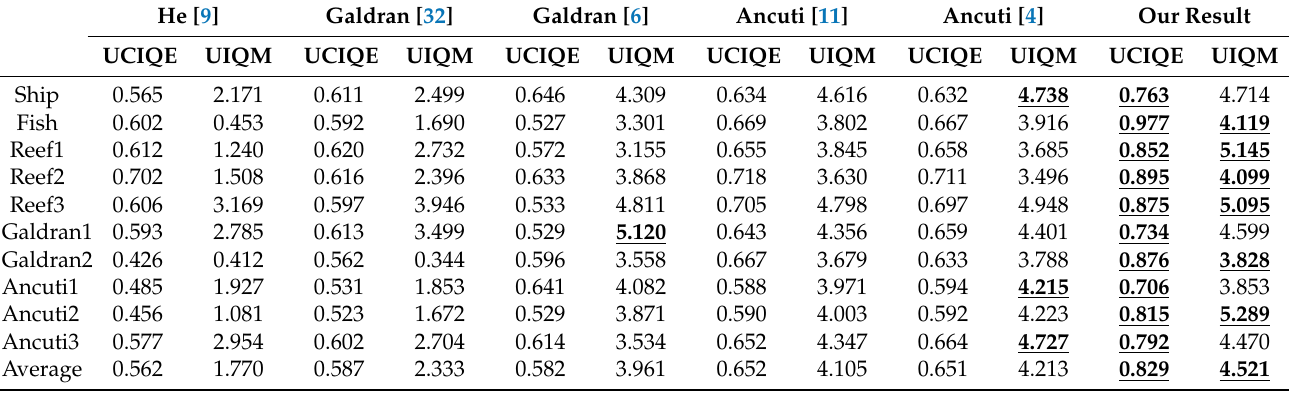
Table 2. Underwater image enhancement evaluation based on the UCIQE and UIQM metrics. The larger the metric, the better the image.